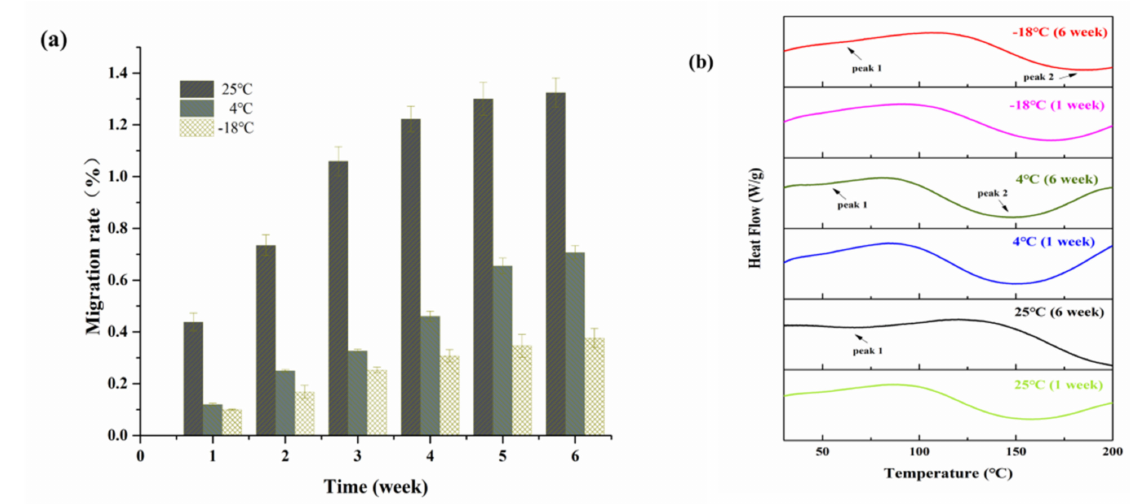
Figure 1. The glycerol migration rate ( a ) and DSC plot ( b ) of SPI edible films stored at different temperatures (25 ◦ C, 4 ◦ C, and − 18 ◦